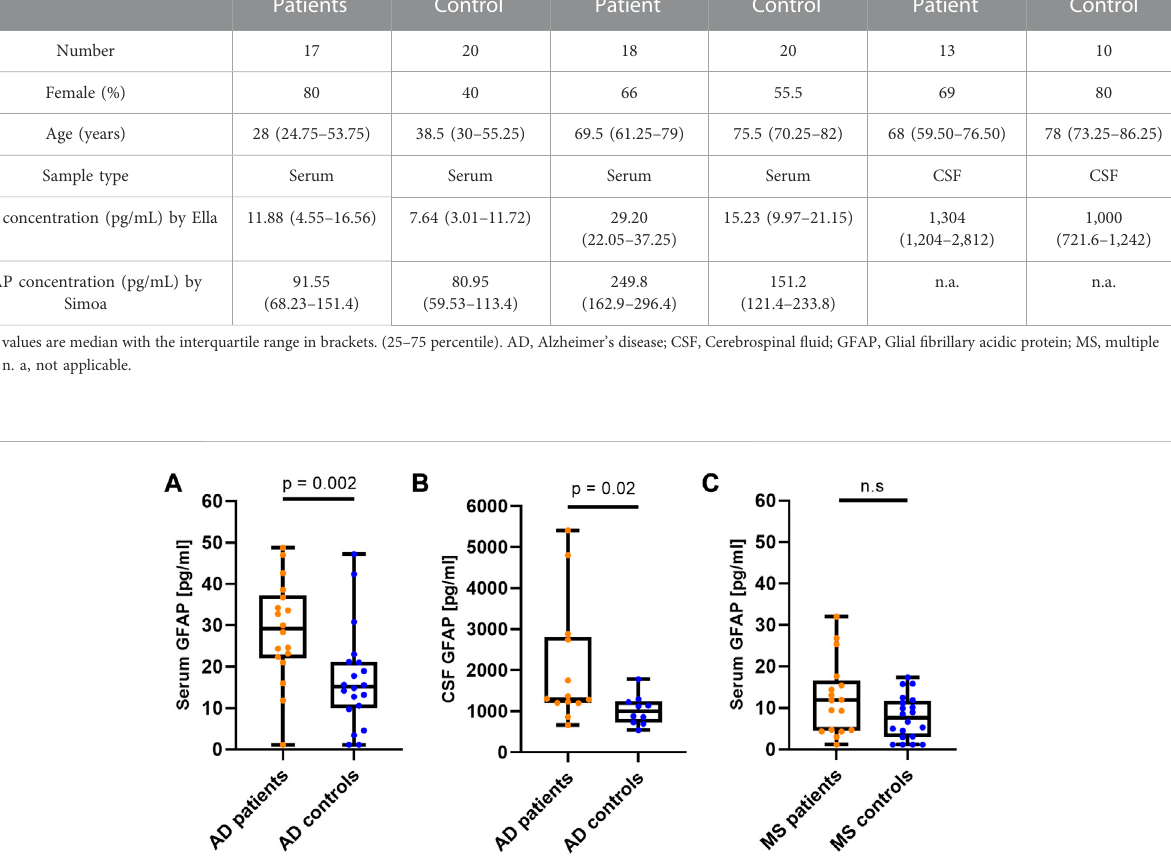
CSFandserumGFAPconcentrationresultindiagnosticgroups.SerumandCSFGFAPlevelsinpatientswithADandMScomparedtocontrolpatients applying the newly developed micro fl uidic assay. (A) Serum GFAP levels in AD. (B) CSF GFAP levels in AD. (C) Serum GFAP levels in MS. All GFAP concentrationsare displayed as box plots with single patients asdots. Illustratedare themedianconcentration, the25%and 75%percentile, andwhiskers from minimum to maximum. AD, Alzheimer ’ s disease; GFAP, Glial fi brillary acidic protein; MS, multiple sclerosis; n. s, not signi fi